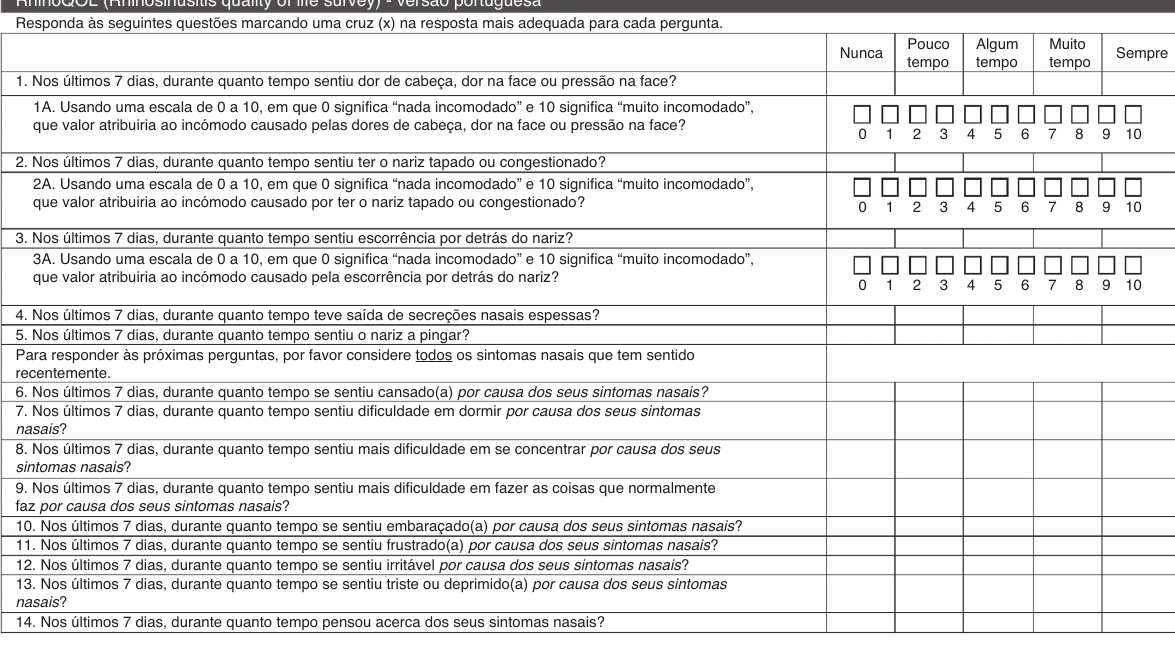
RhinoQOL --- Portuguese